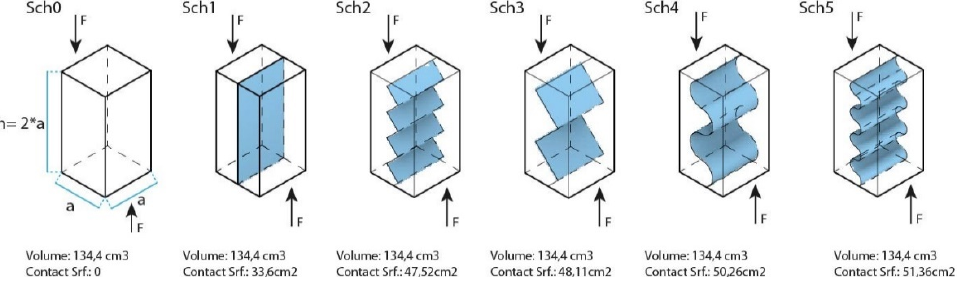
Figure 3. Meso-scale samples for shear tests. Table 1. Surface and geometry of the binding interface of the test specimens described in Figure 1.